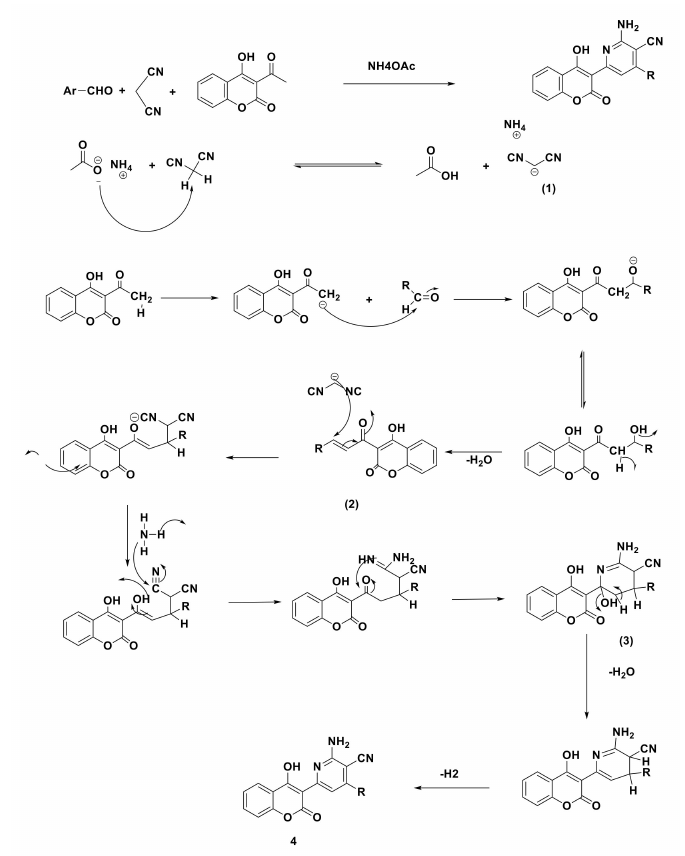
Scheme 2. Plausible reaction mechanism for the formation of the 2-amino-4-hydroxy-6-(4-hydroxy-2- oxo-2H-chromen-3-yl)nicotinonitrile 4